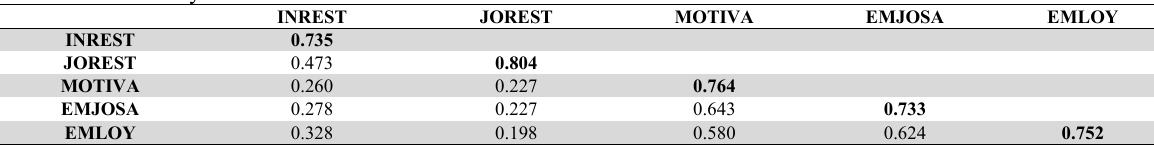
Discriminant Validity